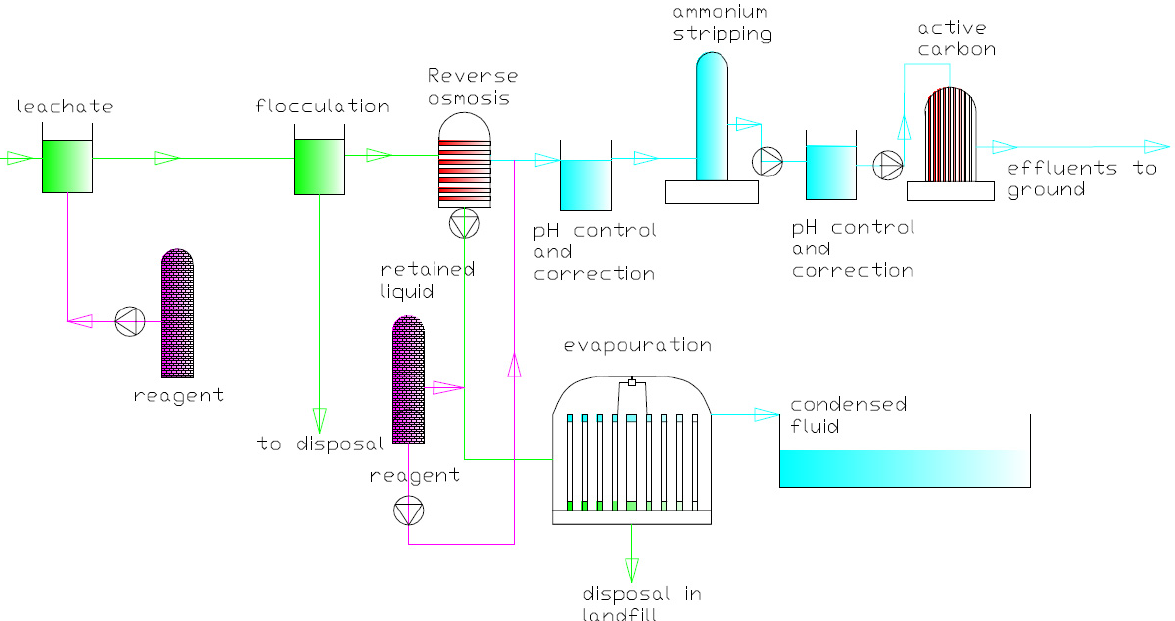
Figure 3. Unifilar diagram for the treatment plant in Scenario